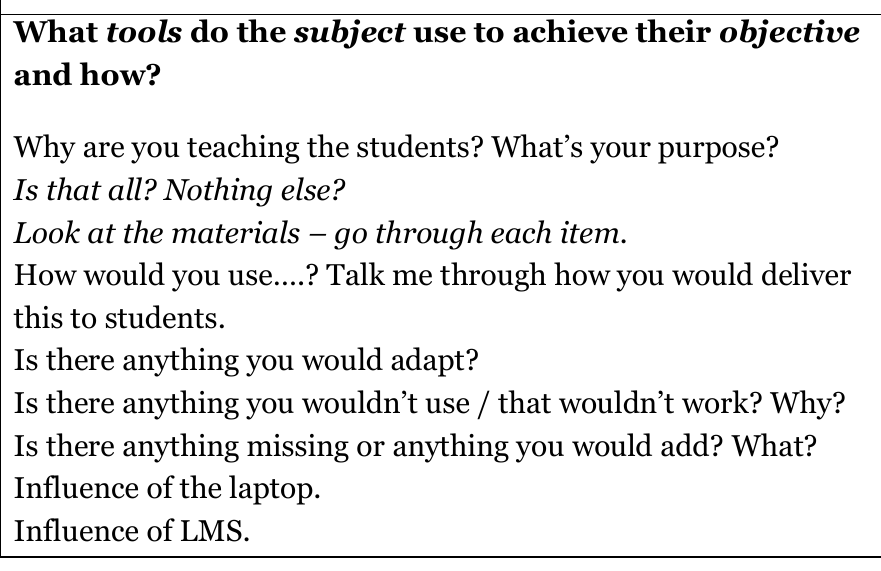
Table 5: actual interview protocol example with